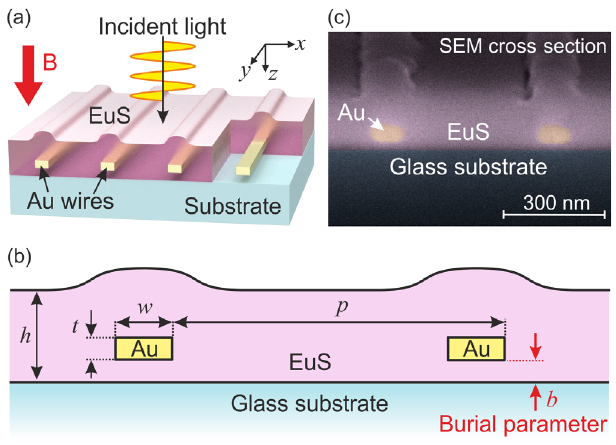
FIG. 1. (a),(b) Schematic drawing of the sample geometry. p , nanowire period; t , w , gold nanowire thickness and width. The wires are buried with a distance b between the glass substrate and their lower edge. The nominal thickness of the EuS magneto- optical waveguide is h , which is increased near the position of the gold nanowires. (c) Colorized scanning electron micrograph of the sample cross section. The samples are measured at T ¼ 20